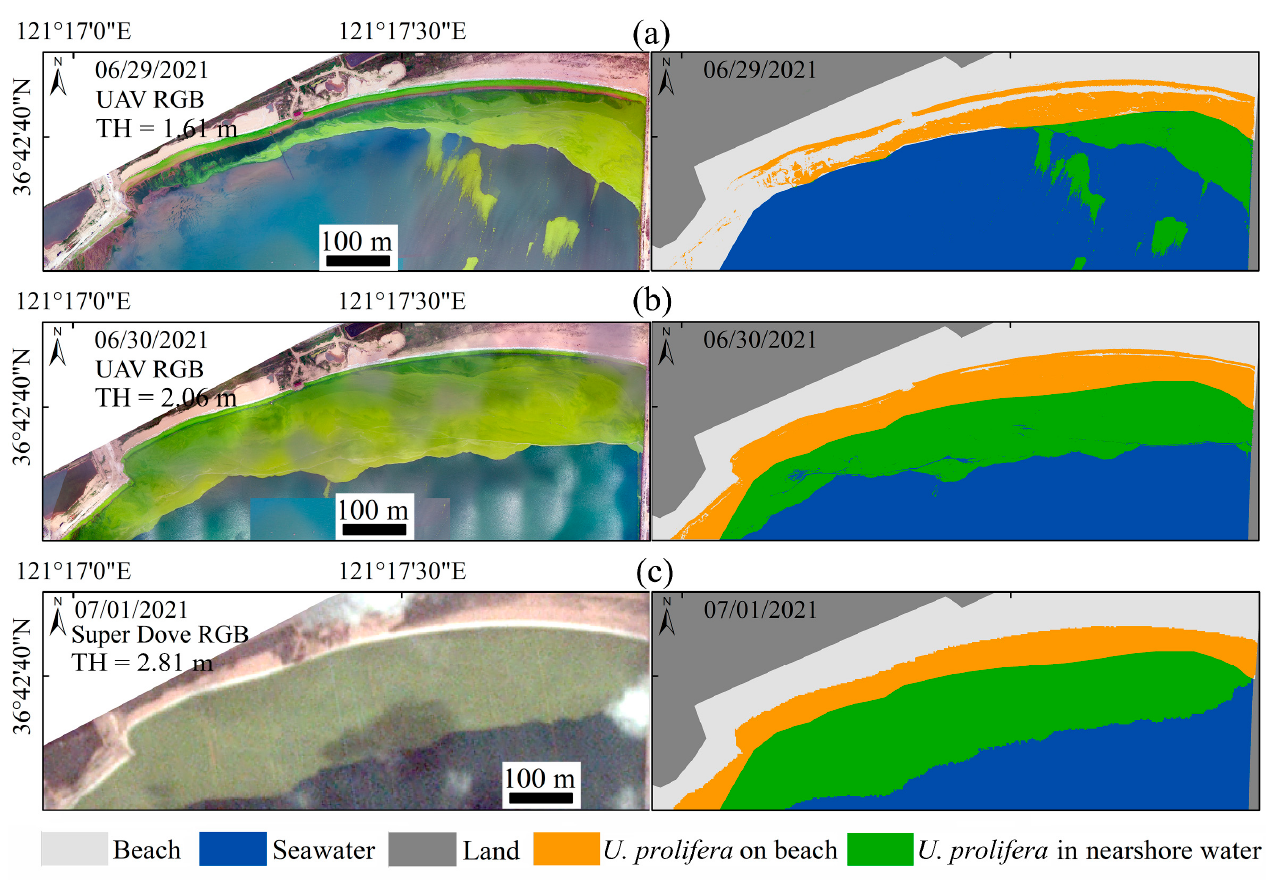
Figure 9. The statistical results for coverage area and biomass of U. prolifera in the P2 area. ( a ) The statistical results for the coverage area of U. prolifera on the beach and in nearshore water; ( b ) the statistical results for the biomass of U. prolifera on the beach and in nearshore water.